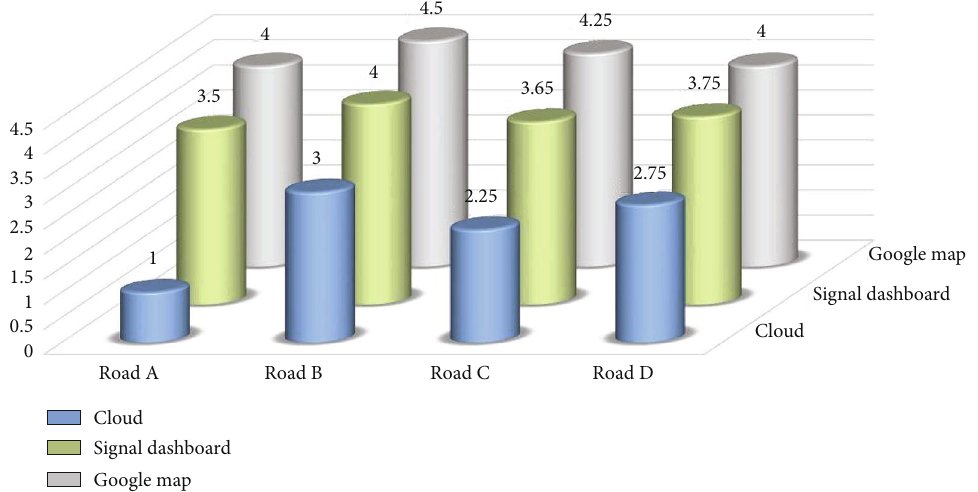
Figure 6: Sync timing communication messages between Cloud, signal dashboard, and Google Map.